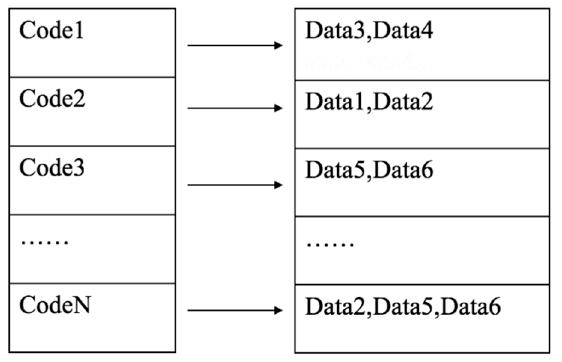
Figure 3. GeoSOT ST-index structure.